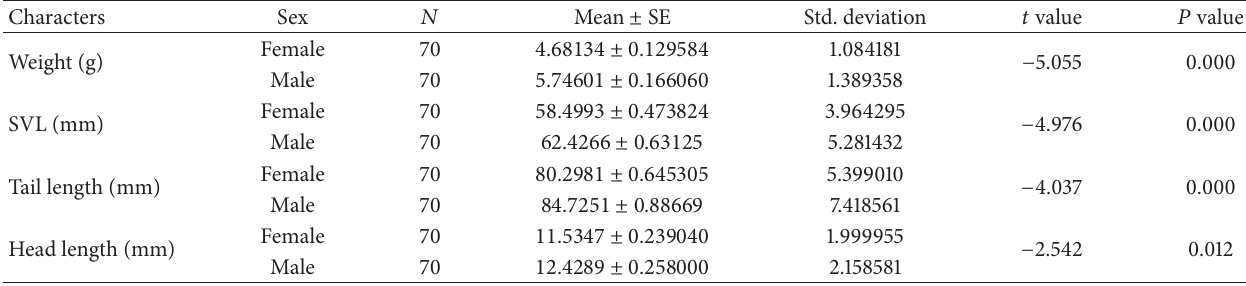
Table 1: Statistics analyses of characters in males and females of T . caspius.